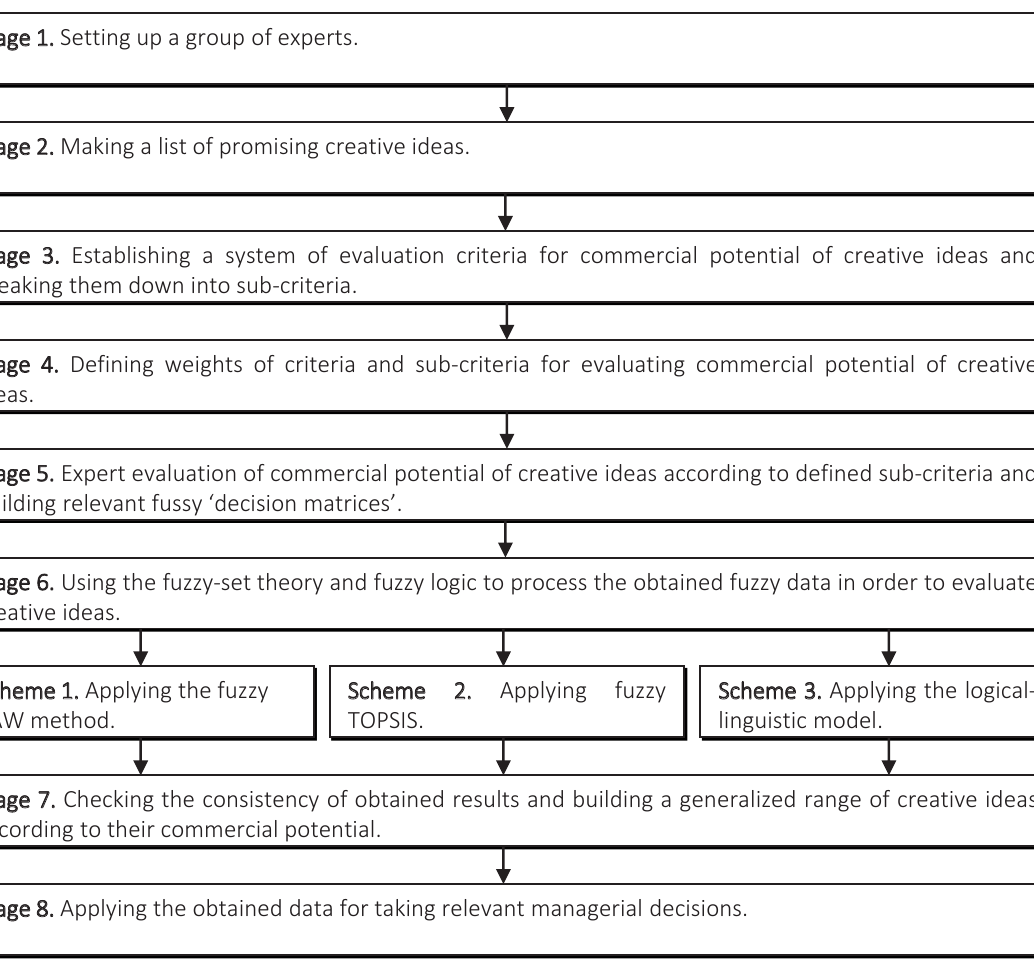
Figure 1. Measuring the commercial potential of creative